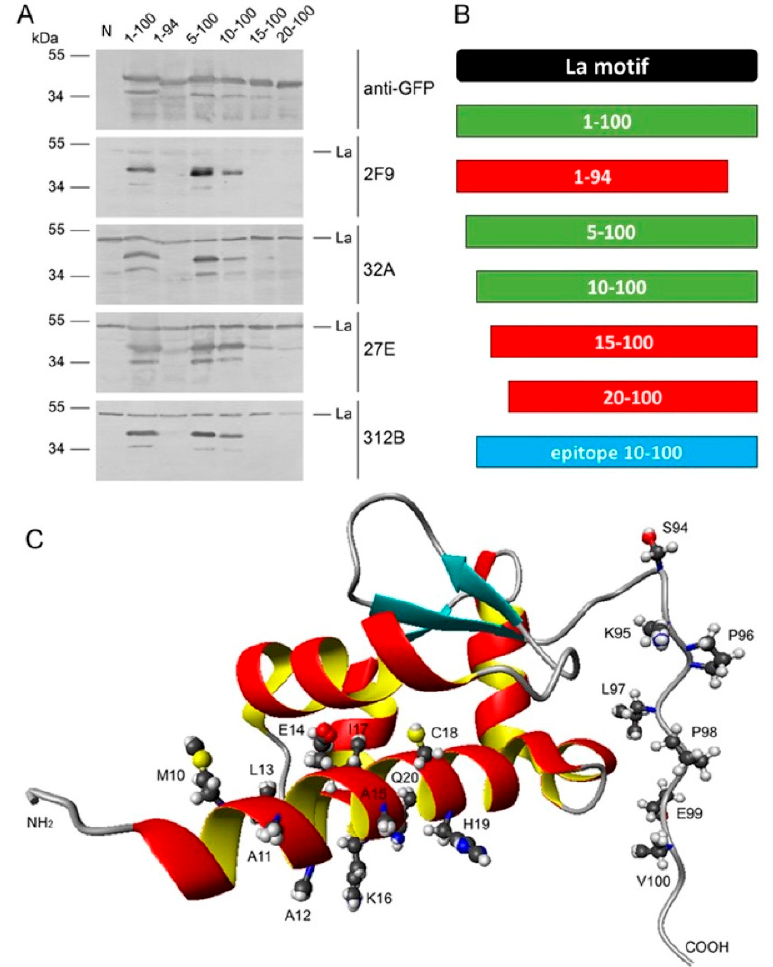
Figure 12. Epitope mapping of the Group 2 anti-La mabs (2F9, 32A, 27E and 312B). HeLa cells were transfected with green fluorescent protein (GFP)-La fusion constructs encoding N- or C-terminally truncated La fusion proteins. Untransfected HeLa cells served as the negative control (N). ( A ) Total extracts were analyzed by SDS-PAGE and immunoblotting using antibodies against GFP or the anti-La mabs (2F9, 32A, 27E und 312B); ( B ) Schematic summary of the selected GFP-La fragments. Immunoreactive GFP-La fusion proteins are highlighted in green. GFP-La fragments which failed to react with anti-La mabs are shown in red. The identified epitope region is highlighted in blue; ( C ) Predicted three-dimensional (3D) structure of the La motif. Epitope mapping locates the epitope(s) recognized by the anti-La mabs (2F9, 32A, 27E und 312B) to the La motif of the La protein. The N-terminal helix may contribute to the stabilization of the 3D structure of the La motif. Interestingly, the random coiled portion at the C-terminus represents the epitope recognized by the anti-La mab 5B9.